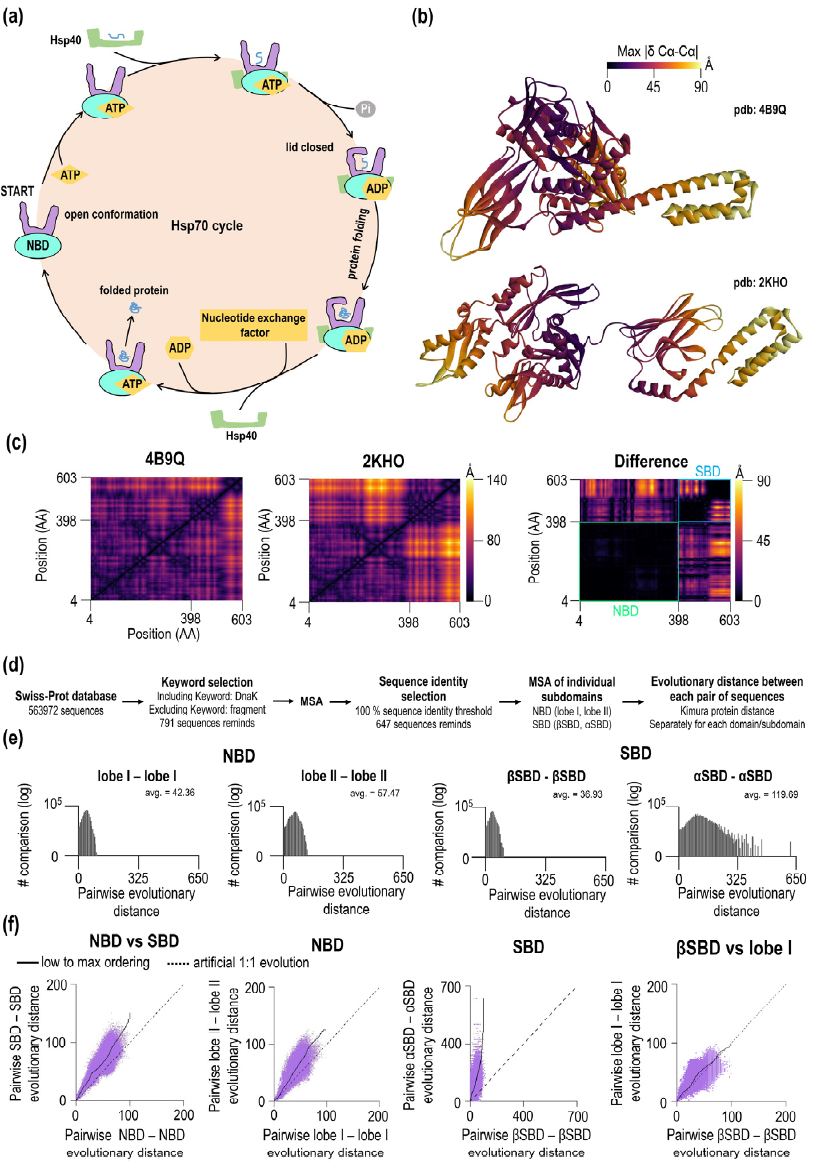
Figure 1. ( a ) Functional cycle of Hsp70. ( b ) Open and closed conformations of E. coli DnaK. The color of each residue is based on the maximum value of the difference of C α -C α distance (Å). ( c ) Heatmaps of C α -C α distances between each pair of residues in the open (avg. = 36.54 Å) and closed (avg. = 45.92 Å) conformations of E. coli DnaK and their differences obtained after subtraction (avg. = 14.12 Å). ( d ) Workflow of collection of sequences, selection and preparation steps for evolutionary distance analysis. ( e ) Histograms of pairwise sequence evolution distances in DnaK subdomains. ( f ) Correlation of evolutionary distances between domains/subdomains including a hypothetical equal rate of changes (dashed